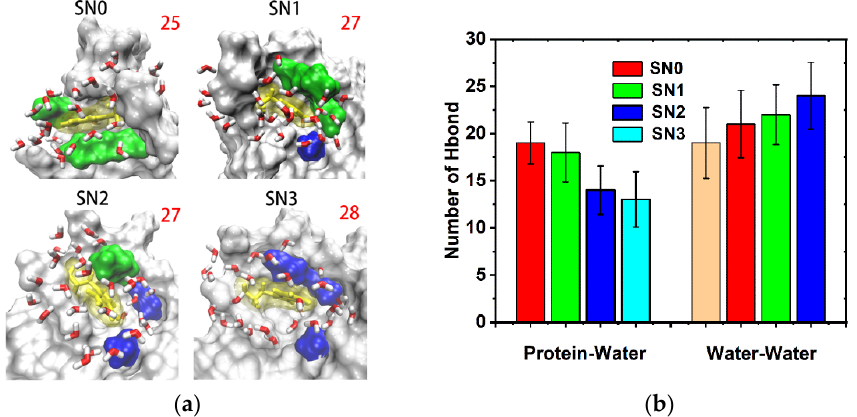
Figure 9. Changes in the number of water molecules and hydrogen bonds around the mutation: ( a ) the number of water molecules within 0.5 nm around W140. W140 is shown in yellow, non-mutated residues are shown in green, and mutated residues are shown in blue, while the number of water molecules is marked in red for each mutation; ( b ) the average number of hydrogen bonds formed by protein and water molecules close to W140, and that of water molecules with themselves. Statistics on 1900 frames with standard deviation.